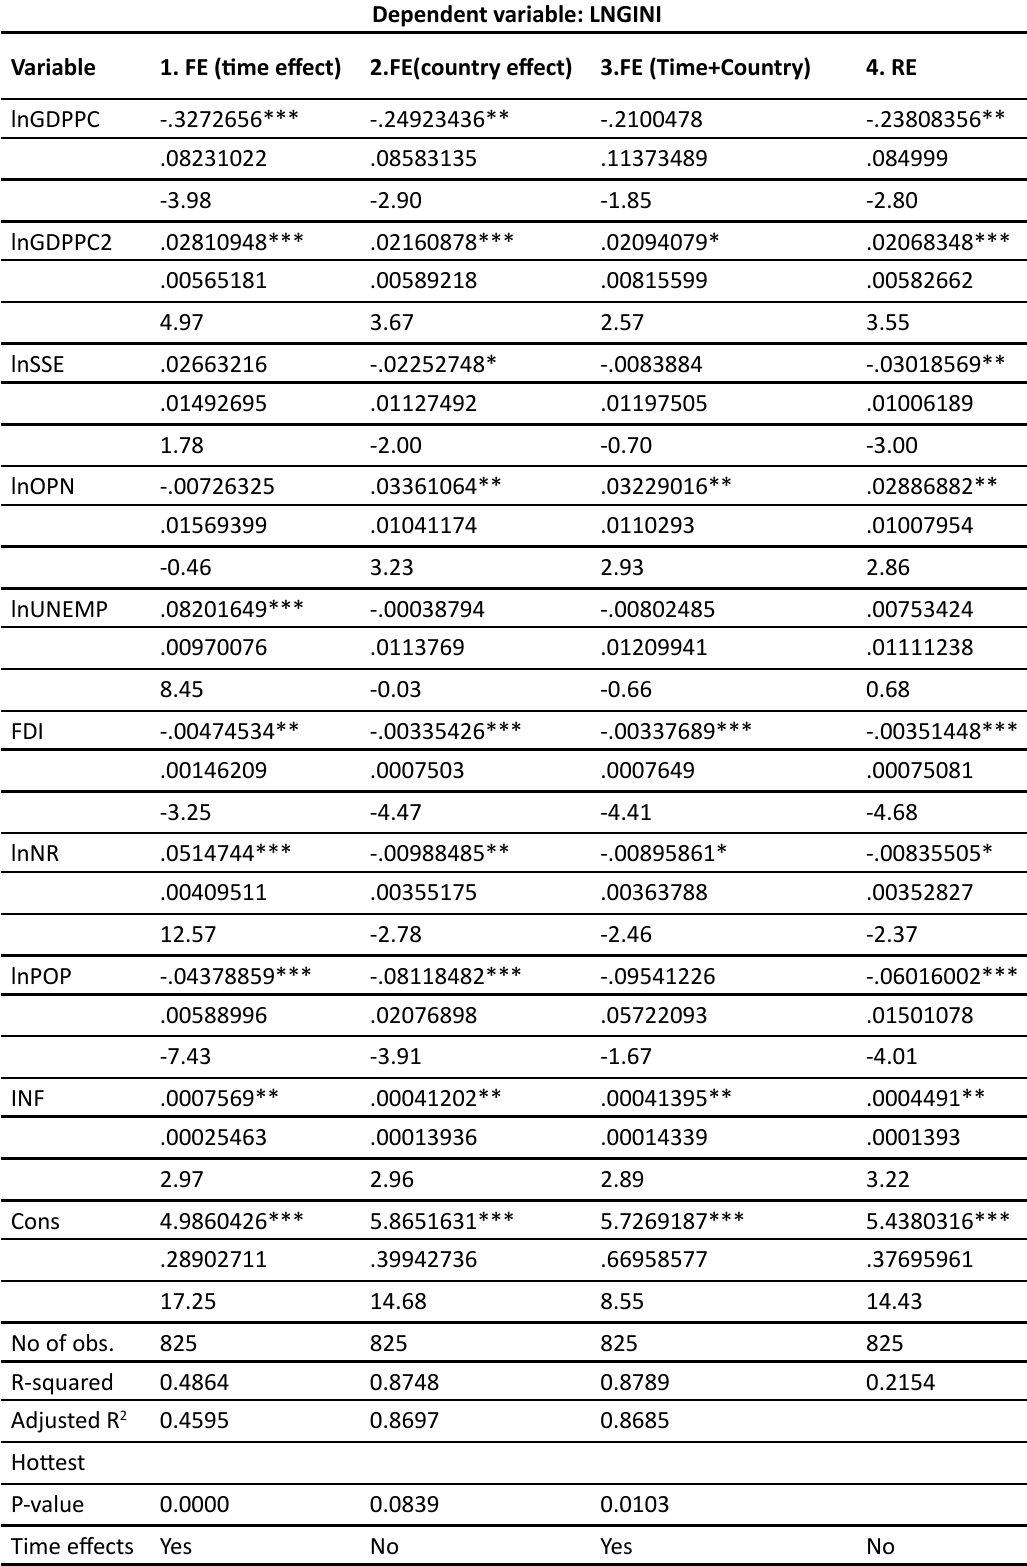
Table 2: Summary of Panel Regression